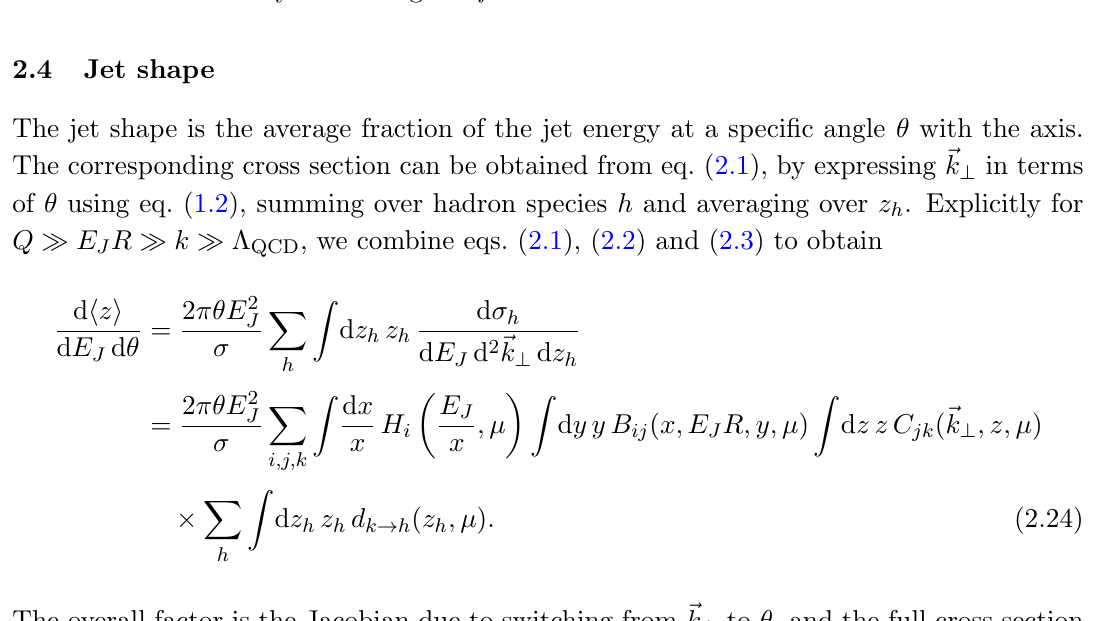
Figure 7 . Left panel: the position of the broadening axis for ’ curves correspond to di(cid:11)erent z 1 values, showing that the Markovian condition is violated, and run over the allowed z 2 range. Right panel: the region in ( z 1 ; z 2 ) where the broadening axis does not lie on a particle. The di(cid:11)erent shades correspond to di(cid:11)erent values of ’ bounds correspond to solutions of (2.22) without taking into account the additional constraints from eq.